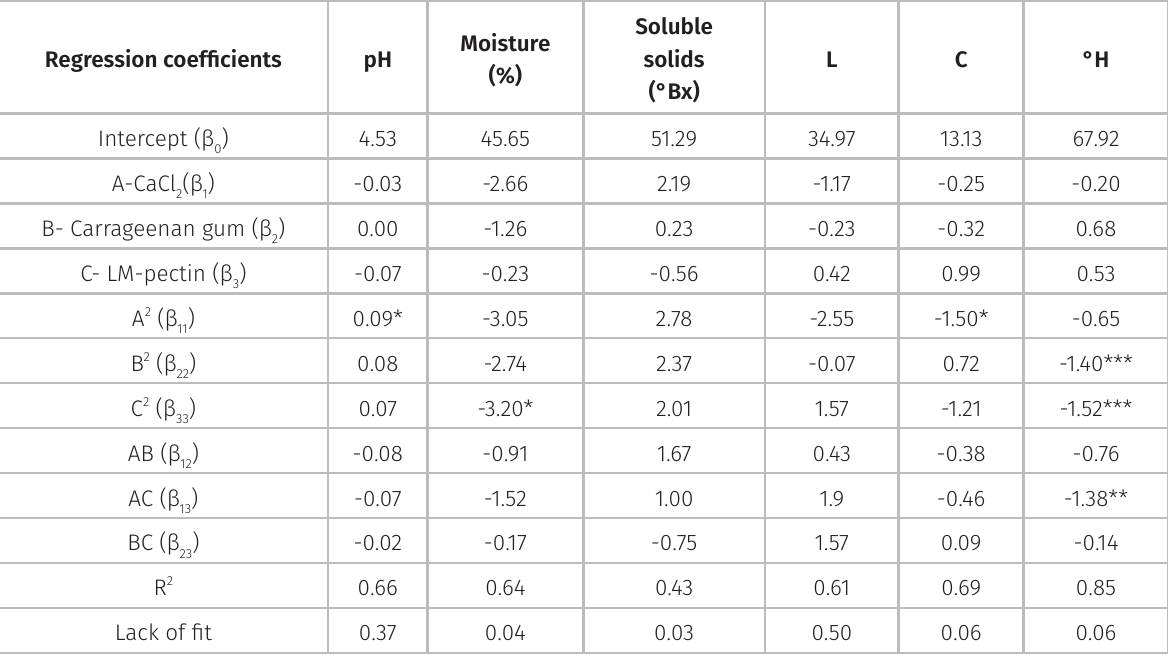
Table II. Regression coefficients for measured responses - physicochemical parameters.